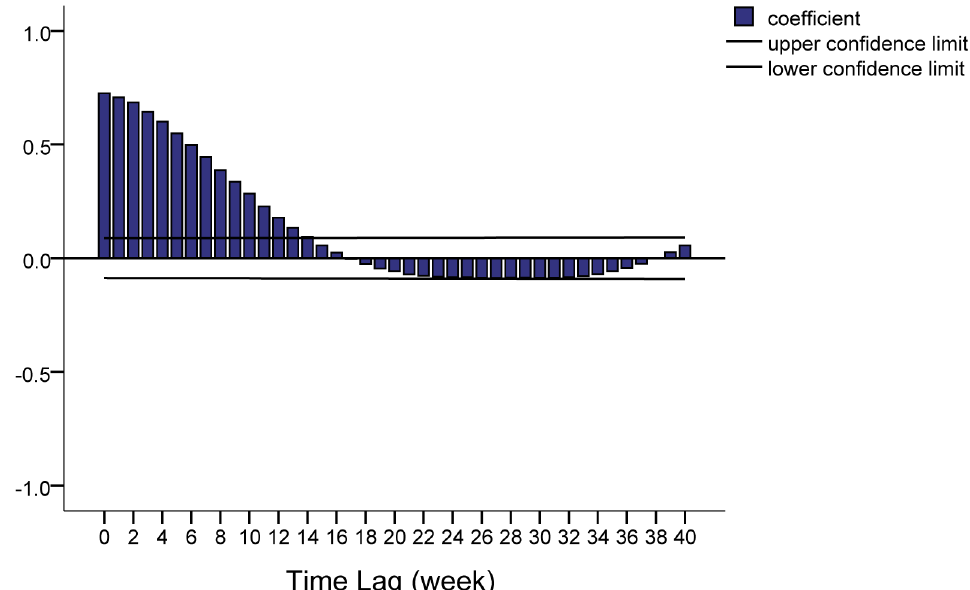
Fig 3. Cross correlations for natural logarithm transformed weekly dengue case counts of Zhongshan and Guangzhou. After making a prior moving average at a span of 5 weeks for each meteorological factor, cross-correlations were also used to find the best lags at which meteorological factors led to Zhongshan epidemics. Fig 4 shows that each treated variable was positively correlated with natural logarithm transformed weekly dengue cases in Zhongshan at different lags (Details in S2 Table). Therefore, we selected the nearest peak as the best lag for each variable. Treated weekly average minimum temperature, relative humidity and rainfall have triggered epidemics in Zhongshan by 6 weeks (correlation coefficient = 0.304), 15 weeks (correlation coefficient = 0.274) and 7 weeks (correlation coefficient = 0.299), respectively.